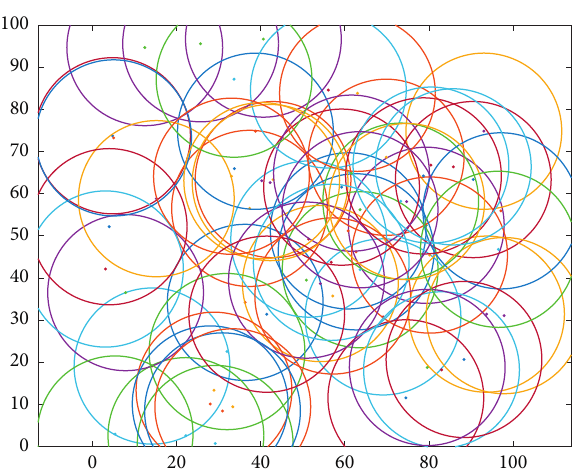
Figure 2: Coverage area in the field.